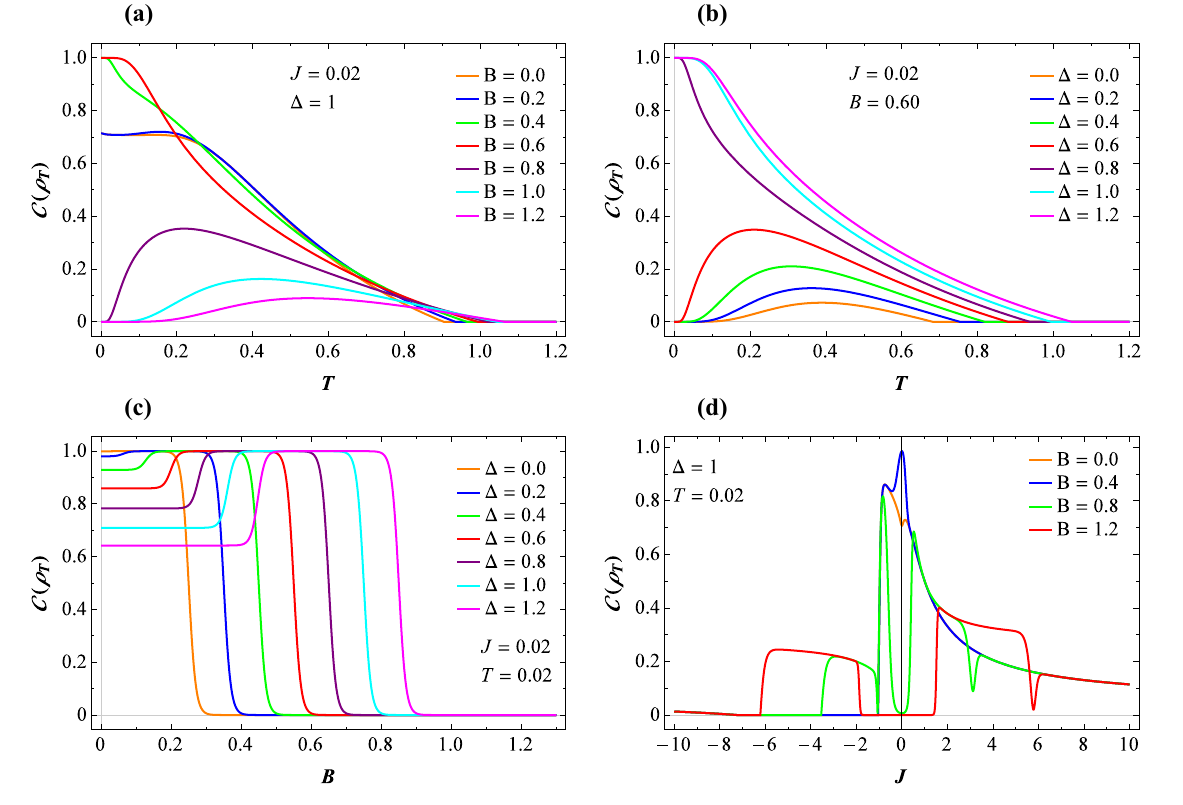
Figure 2. ( a ) Concurrence versus temperature for several fixed values of the magnetic field, taking J = 0.02 and (cid:31) = 1 . ( b ) Concurrence versus temperature for several fixed values of the exchange anisotropy, taking J = 0.02 and B = 0.6 . ( c ) The same function against magnetic field for various values of the exchange anisotropy at low temperature T = 0.02 and fixed J = 0.02 . ( d ) The exchange coupling dependence of the concurrence at low temperature T = 0.02 and fixed (cid:31) = 1 , where different values of the magnetic field are